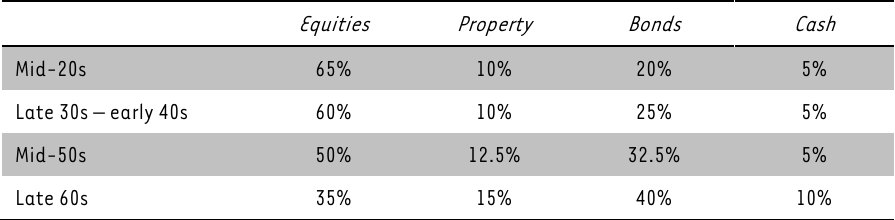
Investment composition based on life cycle position